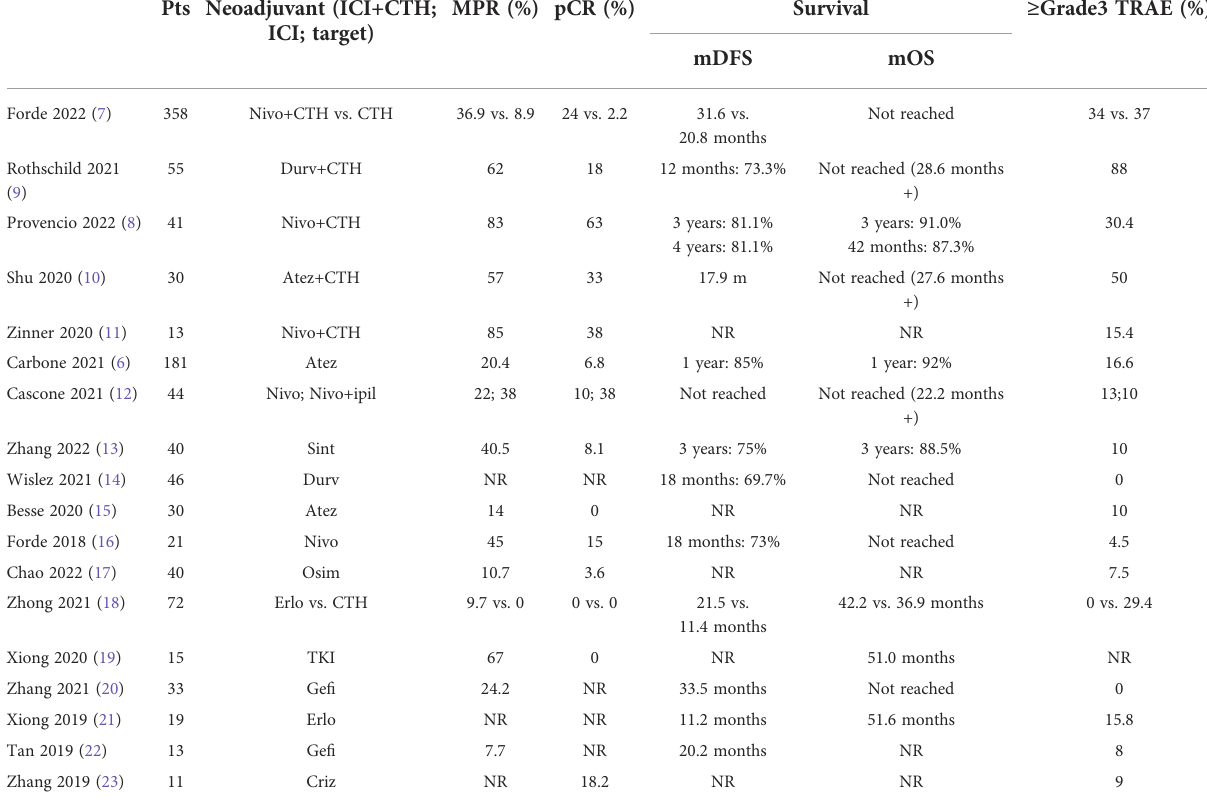
TABLE 1 Summary of the published prospective neoadjuvant therapy trials. Pts Neoadjuvant (ICI+CTH; ICI;